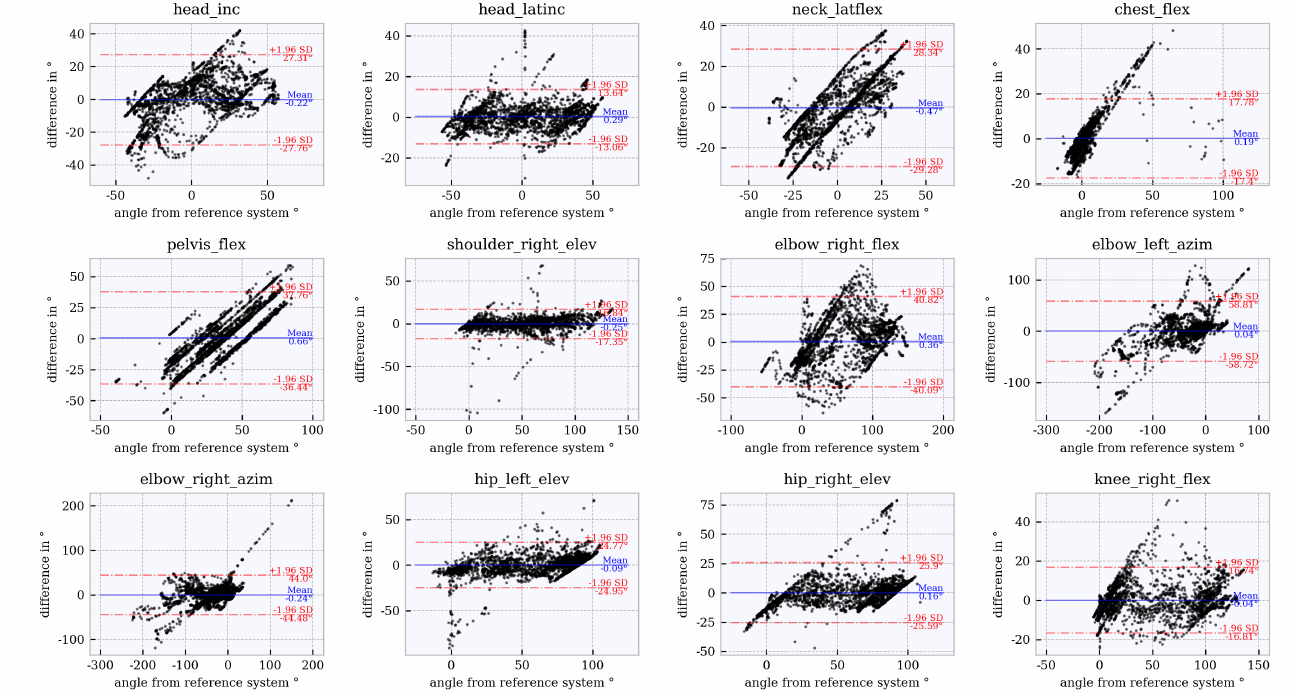
Figure A3. Bland–Altman plot for tracker configuration 6 ; x does not show the average of both systems but the joint angles of the reference system,